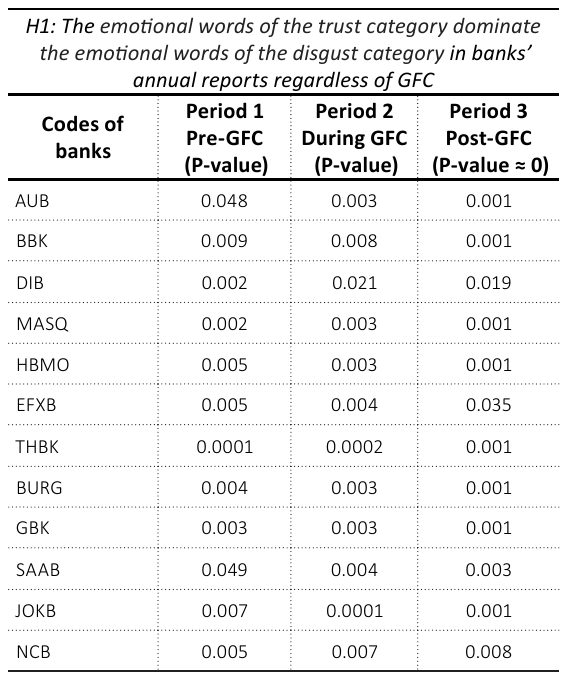
Table 4. Wilcoxon rank-sum test for the emotional words of the trust and disgust categories (One Tail Two-Sample)